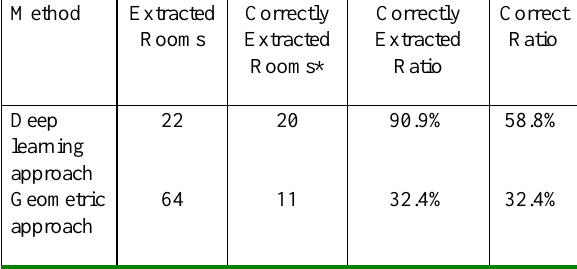
Table 2. Extracted rooms result comparison between the deep learning approach and geometric